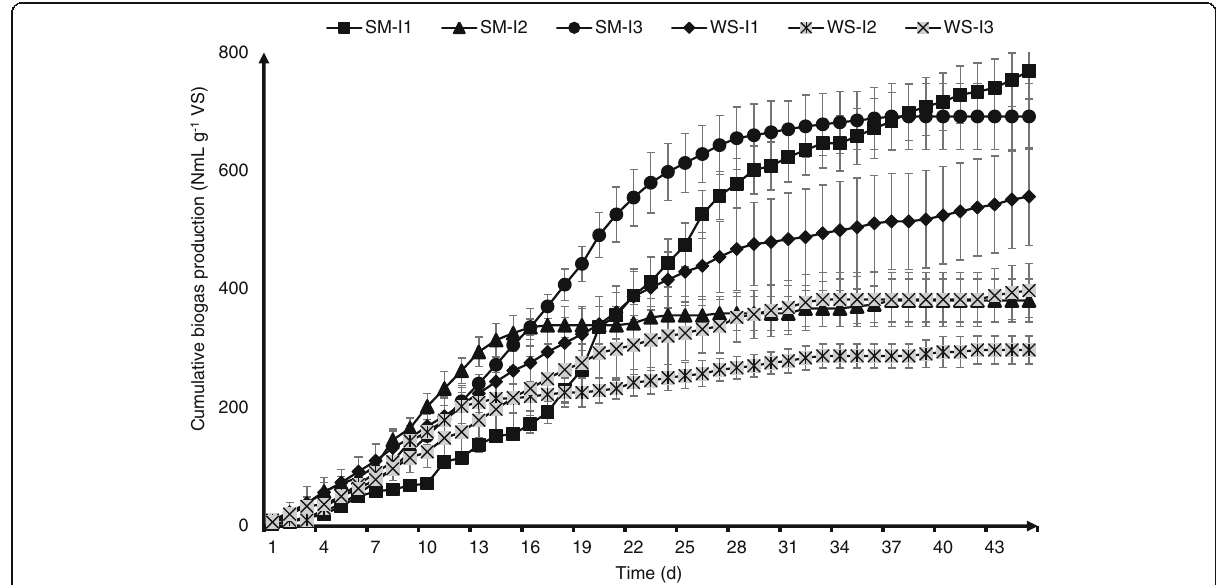
Fig. 1 Cumulative biogas yield from SM and WS inoculated with different